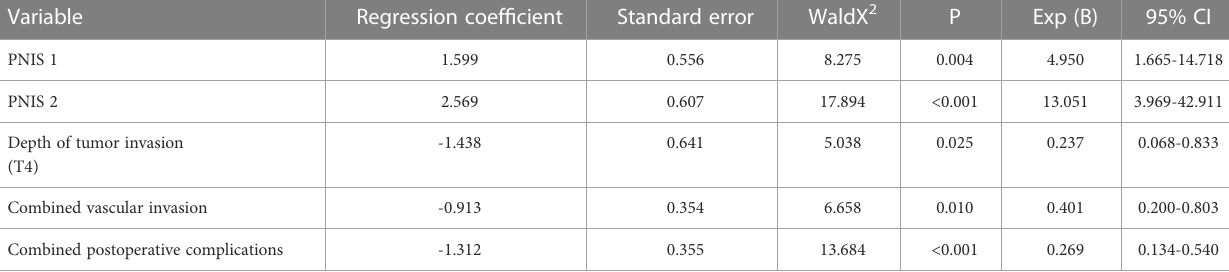
TABLE 5 Cox regression multivariate analysis of postoperative survival rate in patients with locally advanced gastric cancer.